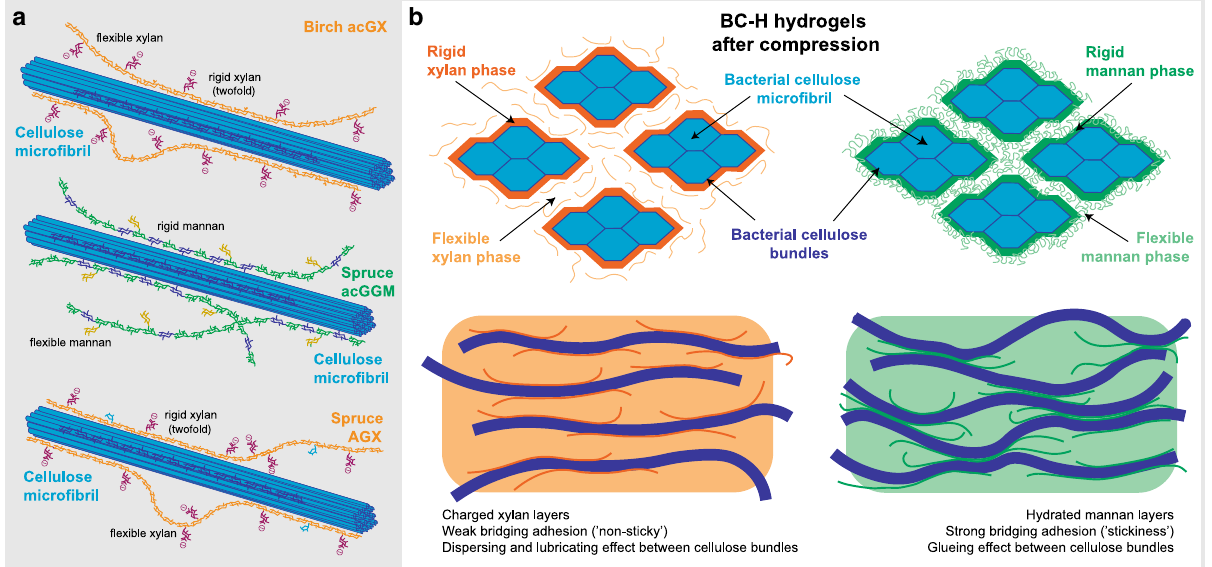
Fig. 5 Proposed organization of the BC-H hydrogels with incorporated wood hemicelluloses. a Molecular interactions between the cellulose micro fi brils and the wood hemicelluloses: birch xylan (acGX), spruce glucomannan (acGGM), and spruce xylan (AGX). Here we depict individual xylan and glucomannan polymers that exhibit both regular molecular motifs interacting with the cellulose surfaces in a rigid phase and non-patterned domains in a fl exible phase. b Proposed scheme for the architecture of the BC-H fi brillar networks. In the rigid phases, the hemicelluloses attain extended conformations directly interacting with the cellulose surfaces. In the fl exible phases, the hemicelluloses may adopt more coiled conformations where they can interact with each other through bridging adhesion of different intensities (stronger for glucomannans, weaker for xylans).The presence of rigid and fl exible phases in BC-H hydrogels has been estimated as 50% for each phase, based on the results from 13 C CP/MAS NMR